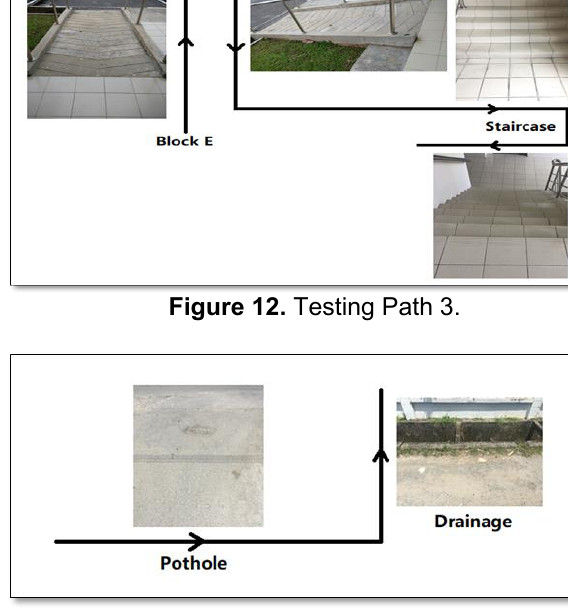
Figure 13. Testing Path 4.